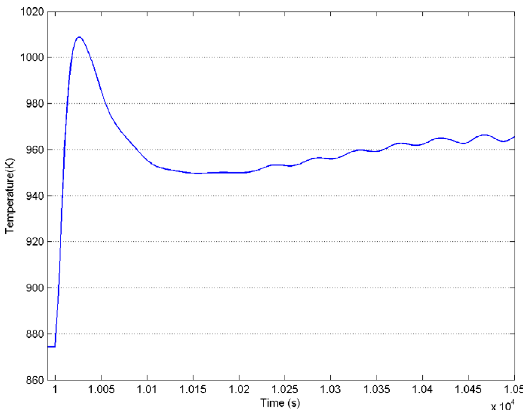
Fig. 15. Maximum cladding temperature.